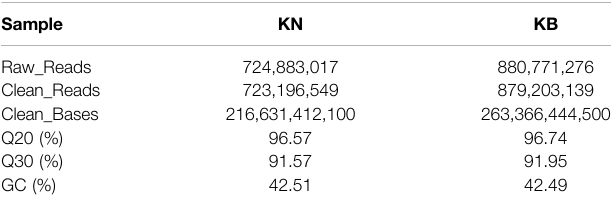
TABLE 4 | Evaluation statistics of sequencing data of keel normal (KN) and keel bend (KB) chicken groups.